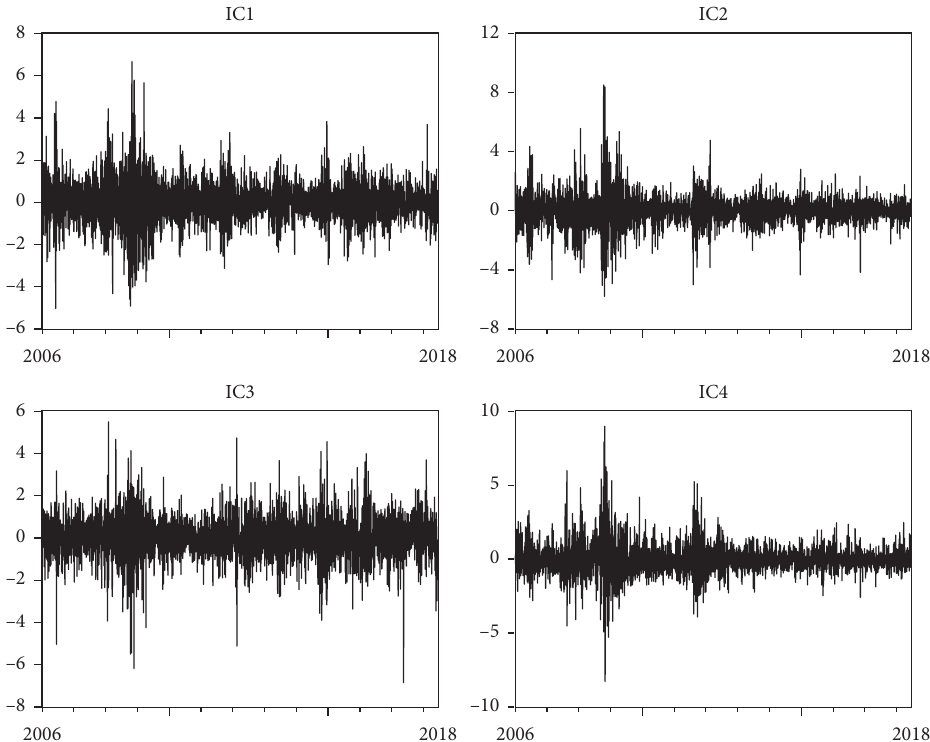
, IC , IC , and IC for cluster 3. (a) IC 1 , (b) IC 2 , (c) IC 3 , and (d) IC 4 . 1 2 3 4